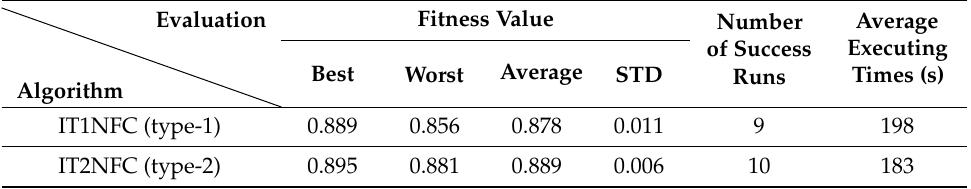
Table 3. Performance comparison of IT1NFC and